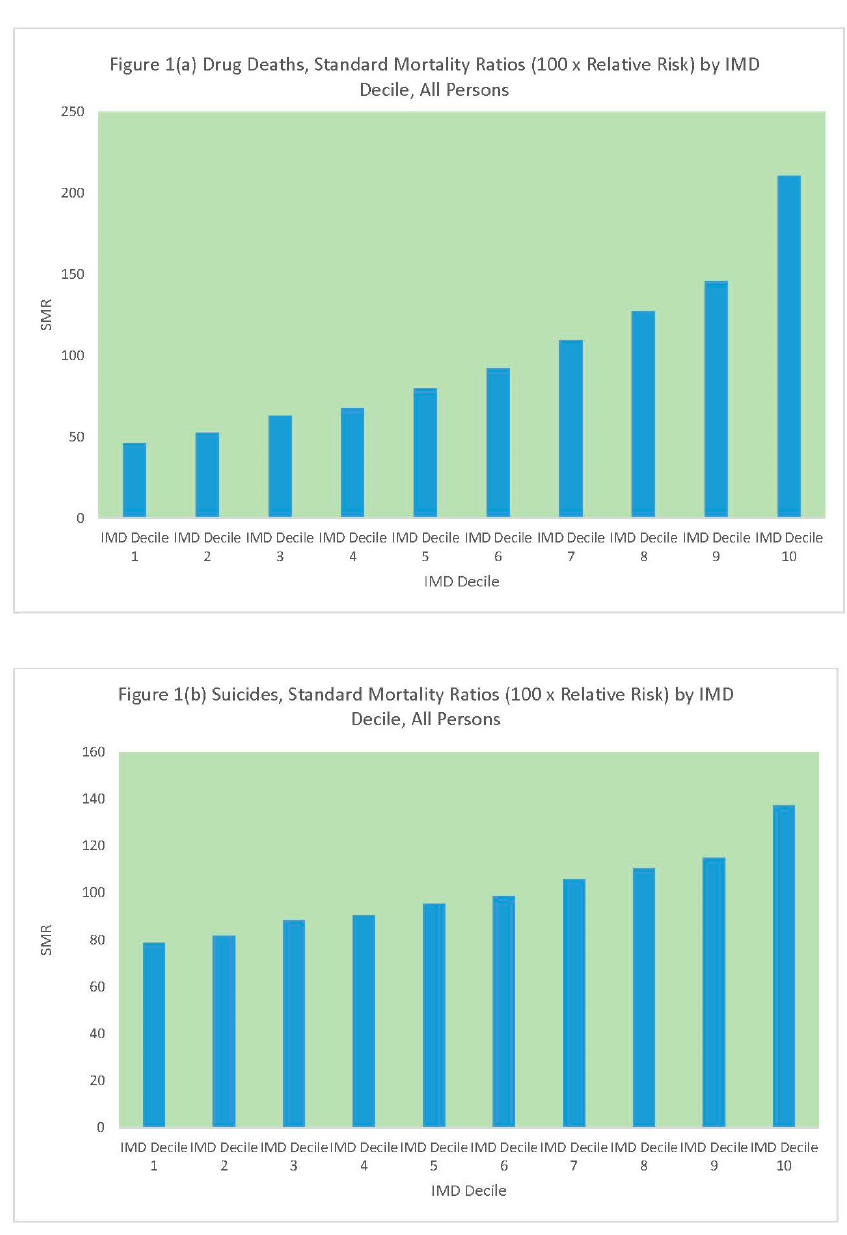
Figure 1. ( a ) DRD SMRs by MSOA Deprivation Decile, ( b ) Suicide SMRs by MSOA Deprivation